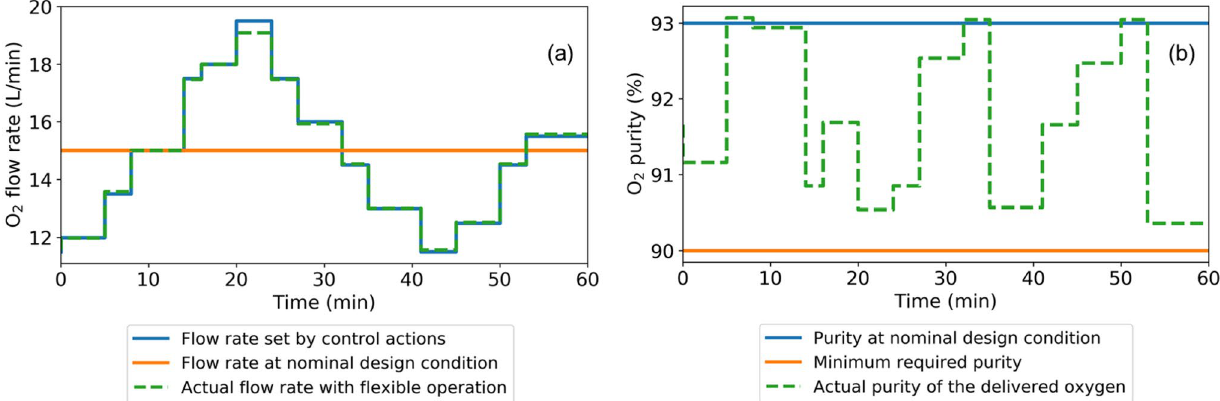
Figure 11. Comparison between actual and target oxygen ( a ) flow rate and ( b ) purity for meeting time-varying oxygen flow rate demand with 90% minimum